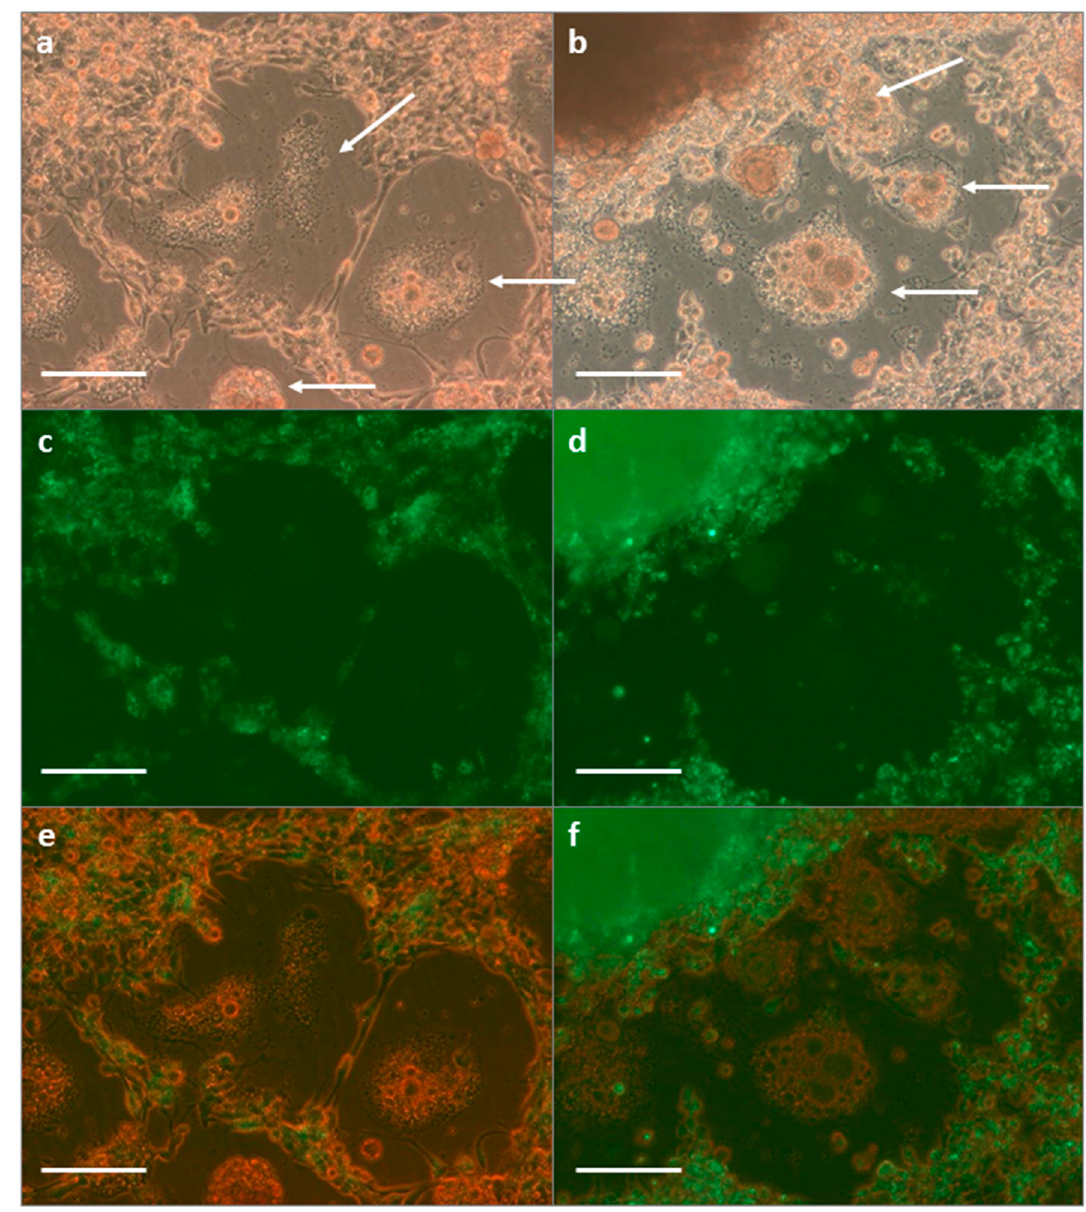
Figure 4. SFV in the tick cell line REE/CTVM28 at 48 HPI, viewed live under brightfield ( a , b ); UV ( c , d ); and combined ( e , f ) illumination, scale bars 100 µm. Two fields are shown ( a , c , f ; b , d , h ) illustrating presence of punctate green fluorescence indicating SFV infection in many small cells, but absence of fluorescence in large foamy cells with midgut morphology (arrows).